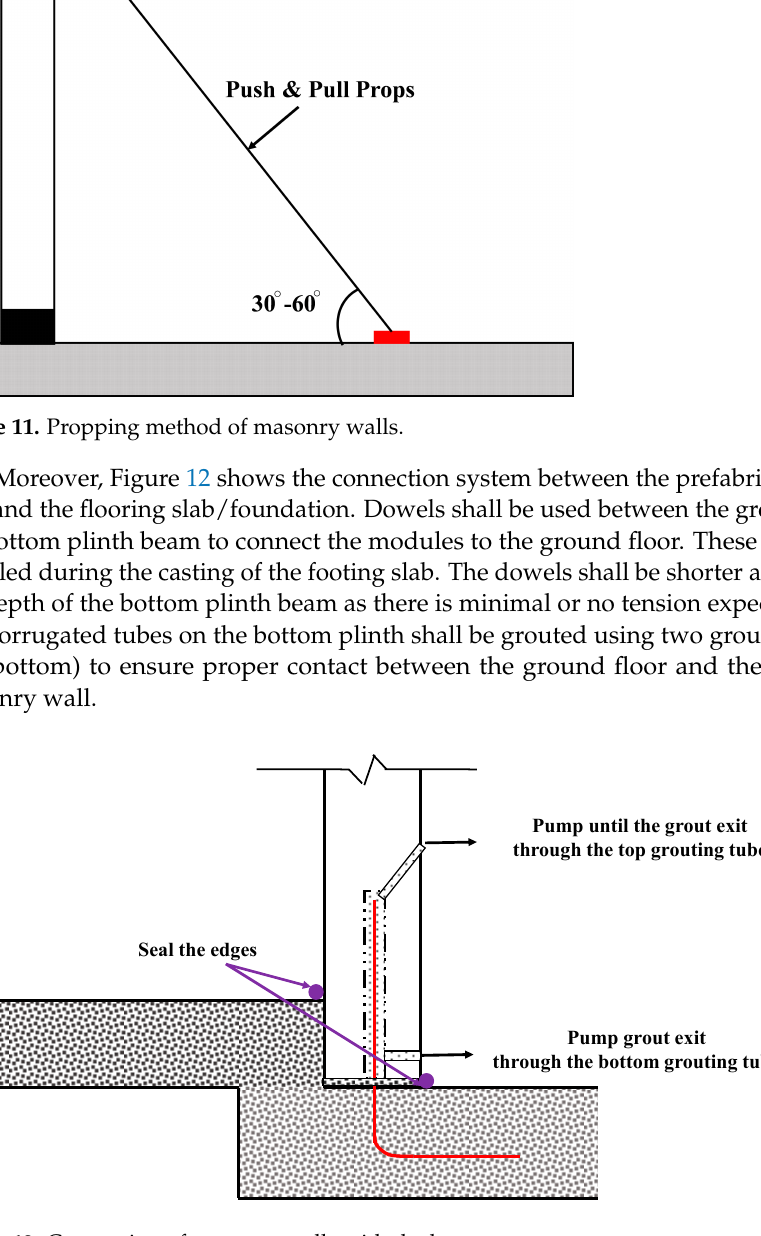
Figure 12. Connection of masonry walls with the base.